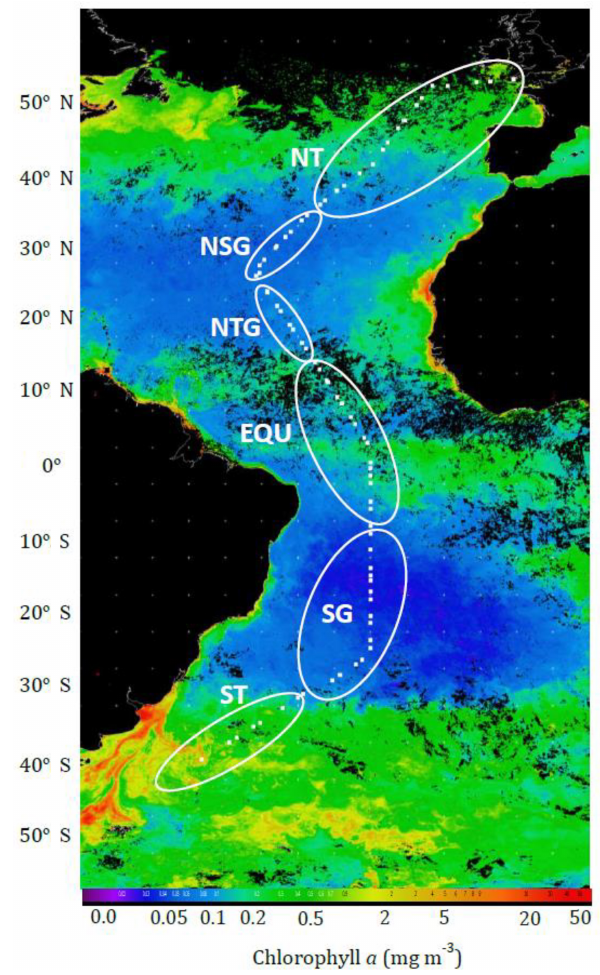
Figure 1. Remotely sensed MODIS-Aqua chlorophyll a composite image of the Atlantic Ocean from November 2009 (image cour- tesy of NEODAAS). White squares represent sampling points and ovals indicate samples within different oceanic provinces, labelled with province names NT (northern temperate), NSG (northern sub- tropical gyre), NTG (northern tropical gyre), EQU (equatorial up- welling), SG (southern gyre) and ST (southern